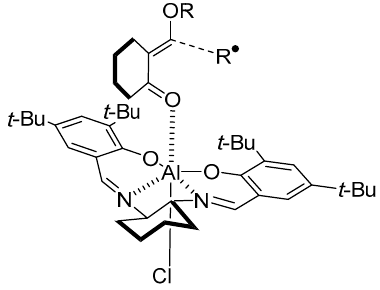
Figure 7. Proposed transition state in the addition of radicals to coordinating ketones.